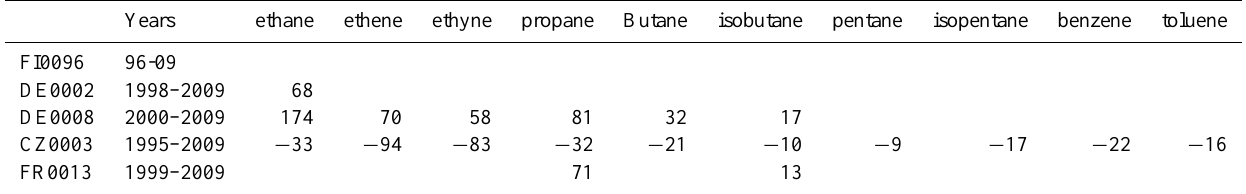
Table 5. Sen’s non-parametric slope estimator of the annual trend [ppt yr − 1 ] for measured light hydrocarbons. Only statistically significant trends are shown.